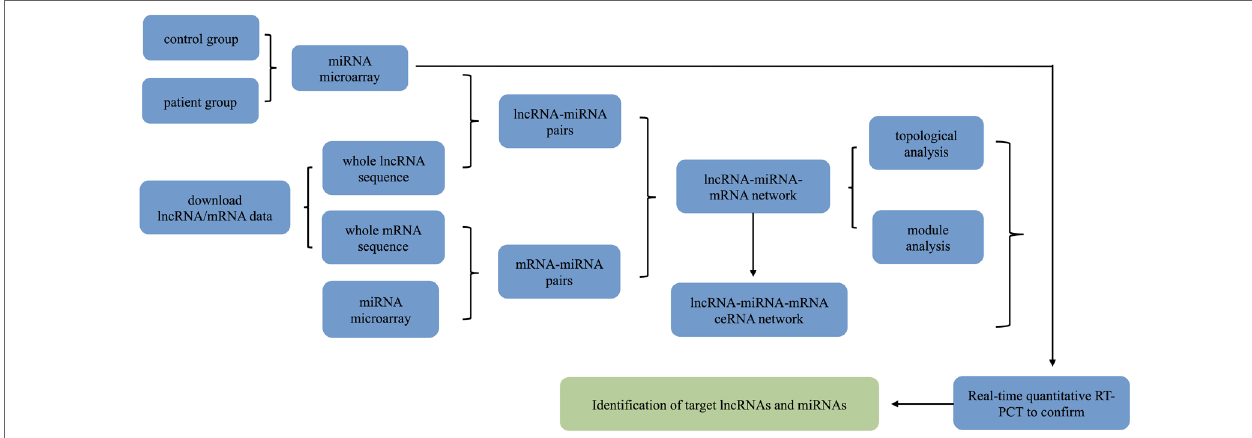
FIgURE 1 | Schematic depiction of the experimental design and flowchart of the steps performed in this study.